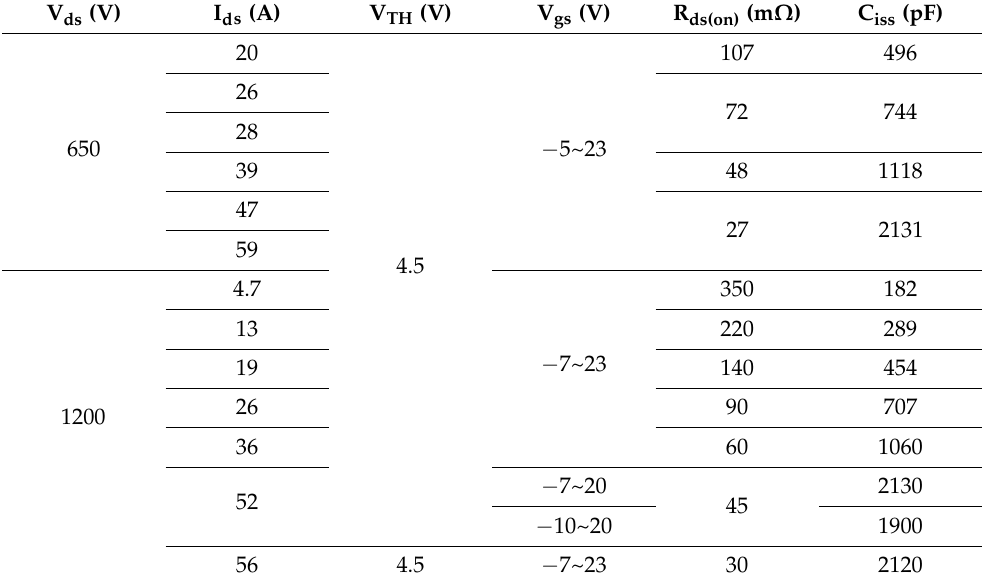
Table 6. Commercial 600~1200 V SiC MOSFETs by Infineon Technologies.